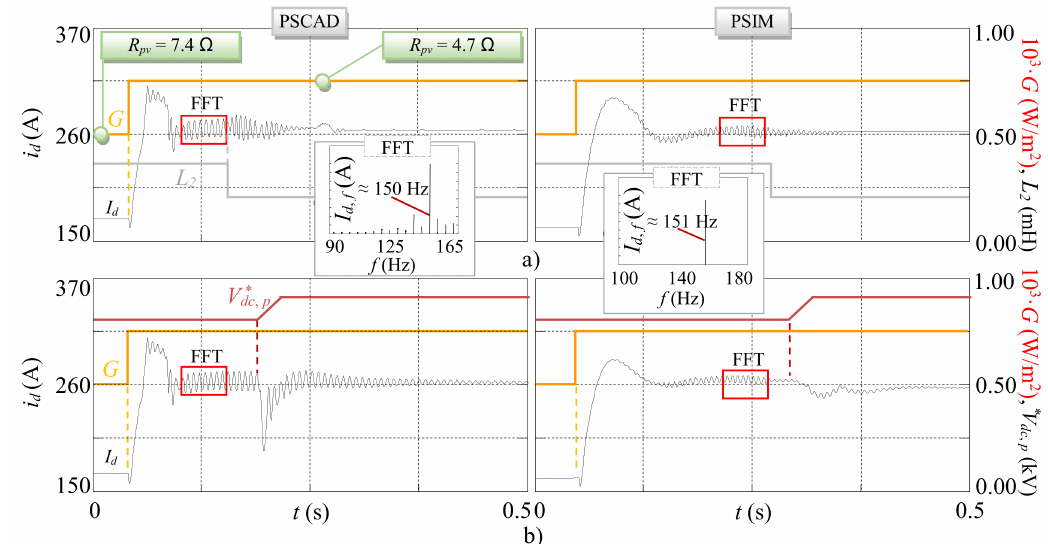
Figure 7. Stability study for PSCAD ( left )/PSIM ( right ) simulations: ( a ) decrease of the qZSI inductor L 2 ; ( b ) increase of the DC-link peak voltage reference V ∗ . dc , p